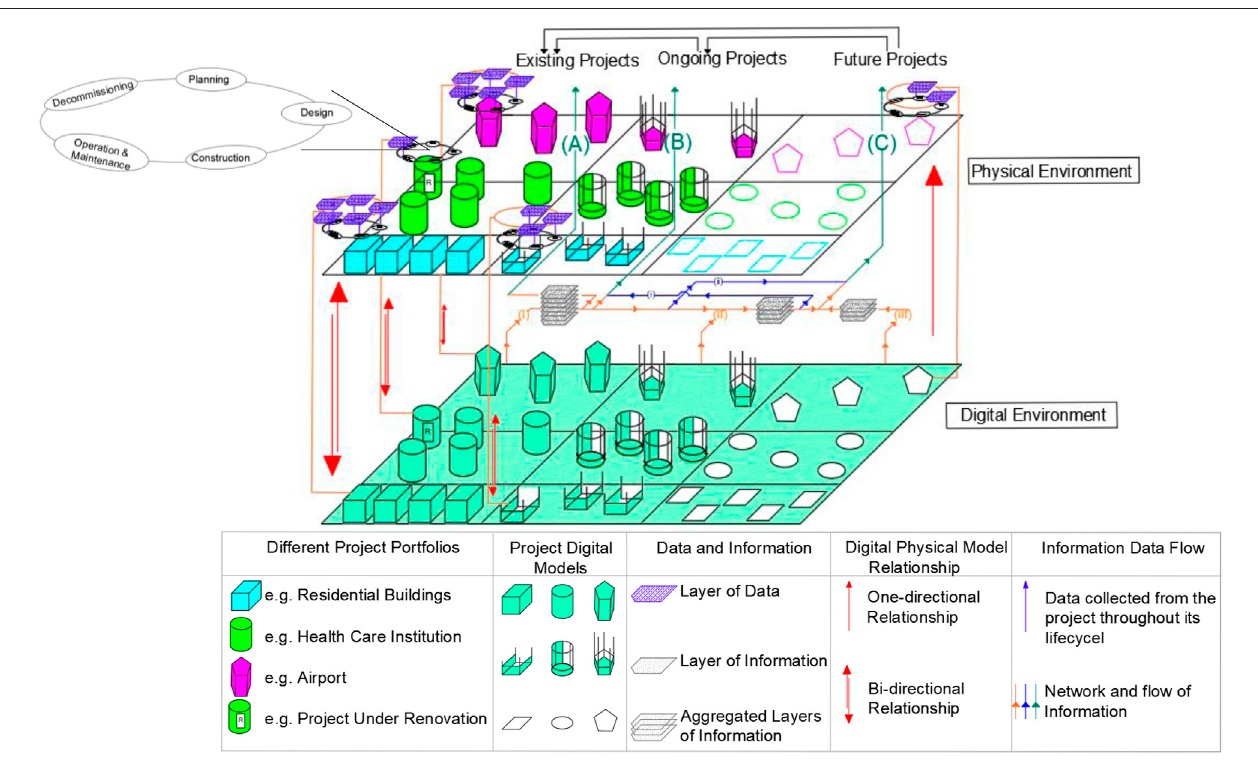
FIGURE 2 | Visual representation of the proposed de fi nition of the Digital Twin of a construction project.